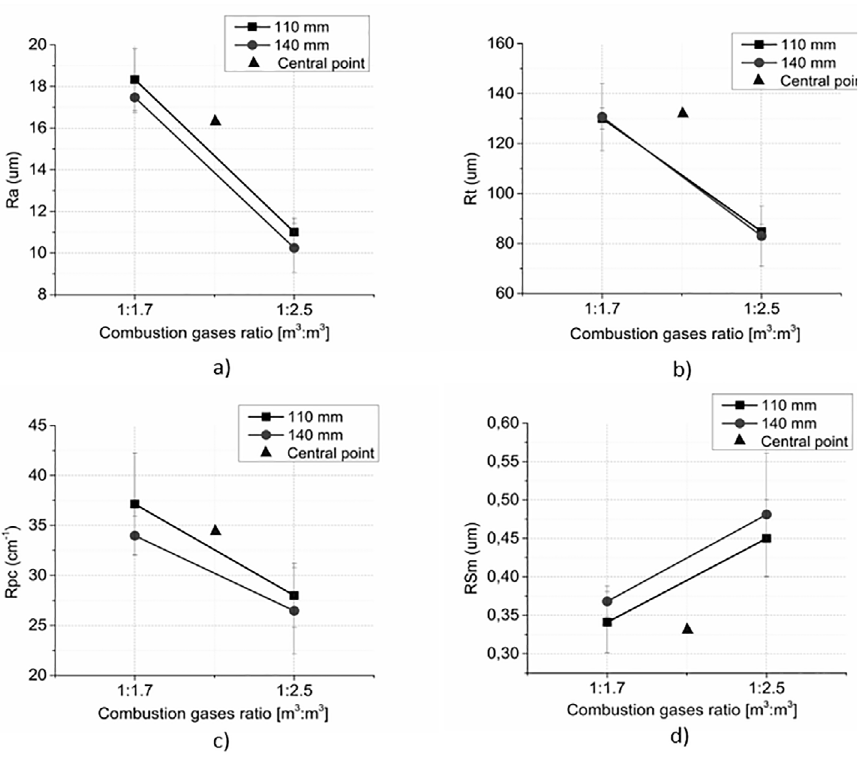
Figure 7. Effect of spraying parameters on roughness parameters a) Ra, b) Rt, c) Rpc, d) RSM